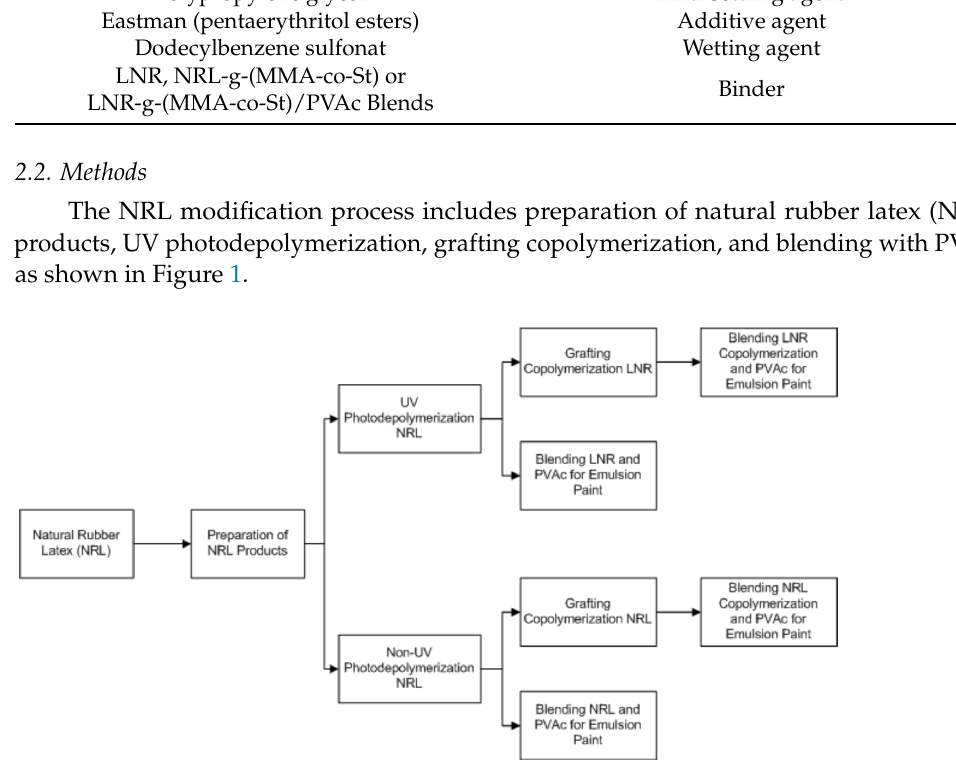
Figure 1. NRL modification process flow